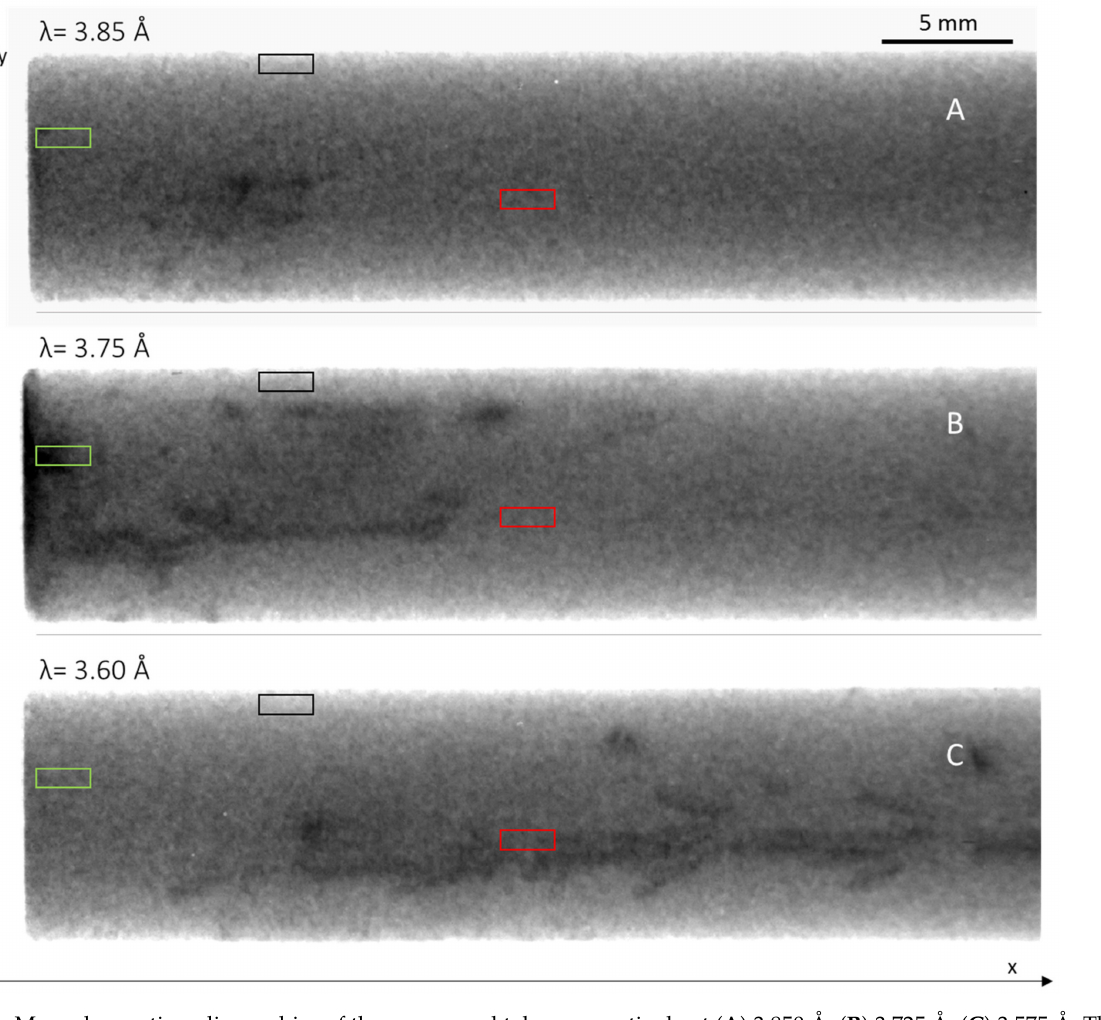
Figure 1. Monochromatic radiographies of the copper rod taken respectively at ( A ) 3.850 Å, ( B ) 3.725 Å, ( C ) 3.575 Å. The presence of black spots is evident in images ( B , C ) as well as a structured branch coherent volume in image ( C ). Image ( A ) also shows the areas used to select transmission intensity profile reported in Figure 2. We set as x direction the horizontal one and as y direction the vertical one. Single crystal grow direction from right to